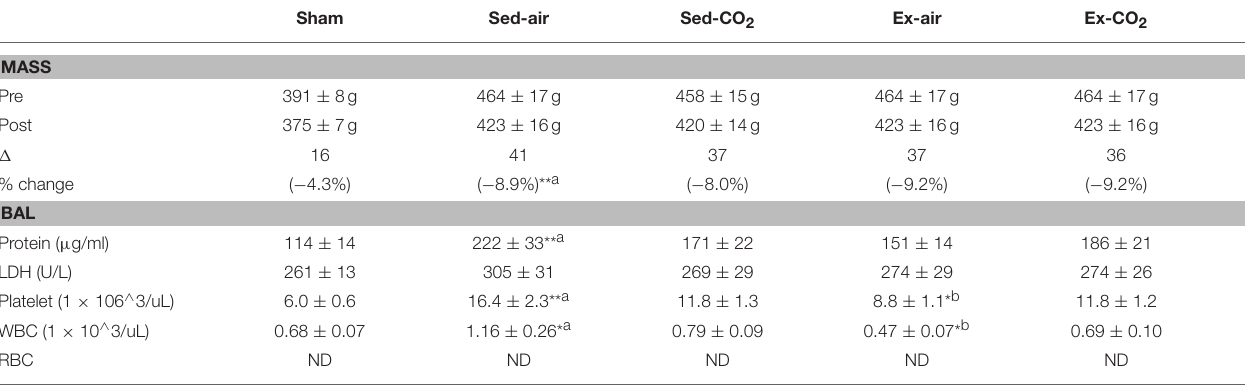
TABLE 2 | Hypobaric hypoxia exposure vs. sham control. Sham Sed-air Sed-CO 2